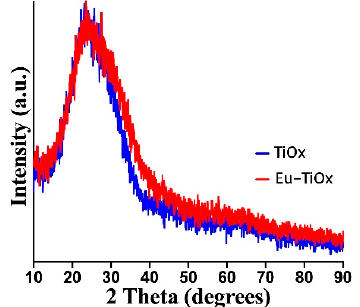
Figure 2. XRD patterns of undoped and Eu-doped TiOx thin films.